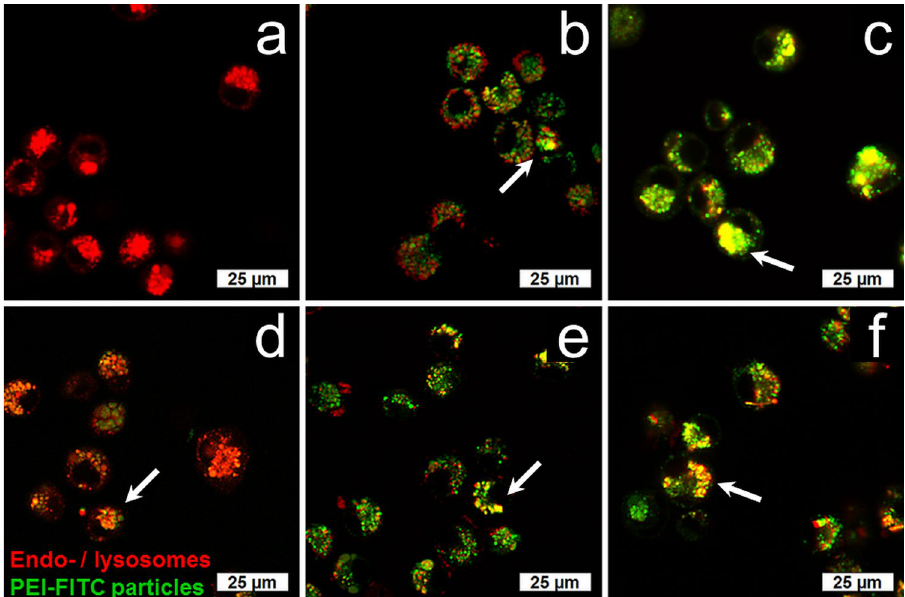
Figure 7. Localization of silica particles in NR8383 alveolar macrophages after incubation with PEI-FITC- labeled silica particles (100 µg mL −1 ) for 24 h by confocal laser scanning microscopy (CLSM). The red fluorescence signals represent endo-/lysosomes stained by LysoTracker Red DND-99. The green signals represent PEI-FITC-labeled silica particles. The overlay of both signals (yellow, indicated by white arrows) indicates a co-localization of particles in endo-/lysosomes. The representative fluorescence micrographs show the results for untreated cells as control ( a ), and cells treated with nanospheres ( b ), submicrospheres ( c